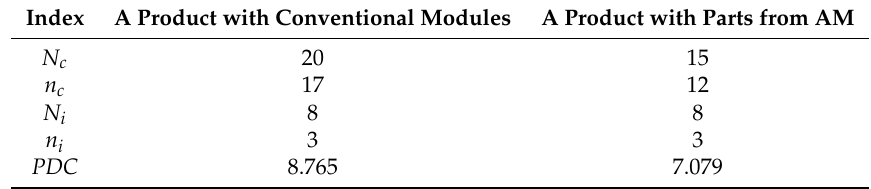
Table 7. Comparison of product disassembly complexity (PDC) when considering modules and parts